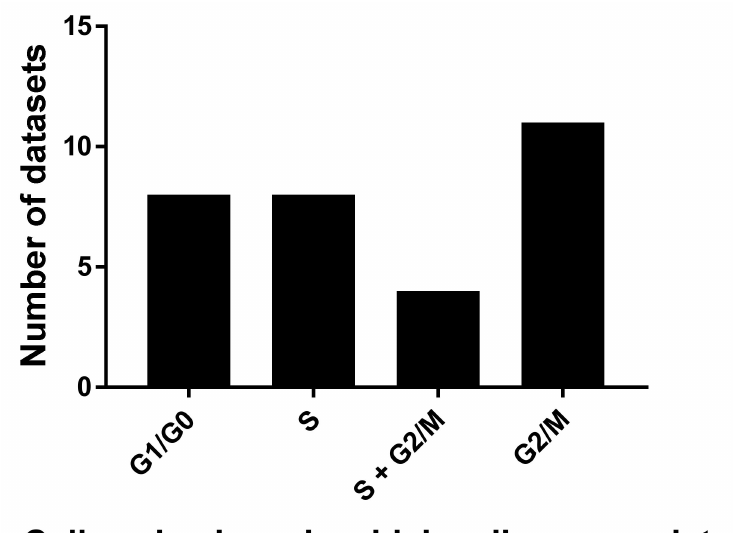
Figure 3. Cordycepin arrests cells in different cell cycle stages. 31 flow cytometry datasets from 18 papers were examined for the cell cycle stage in which cell numbers are significantly increased after cordycepin